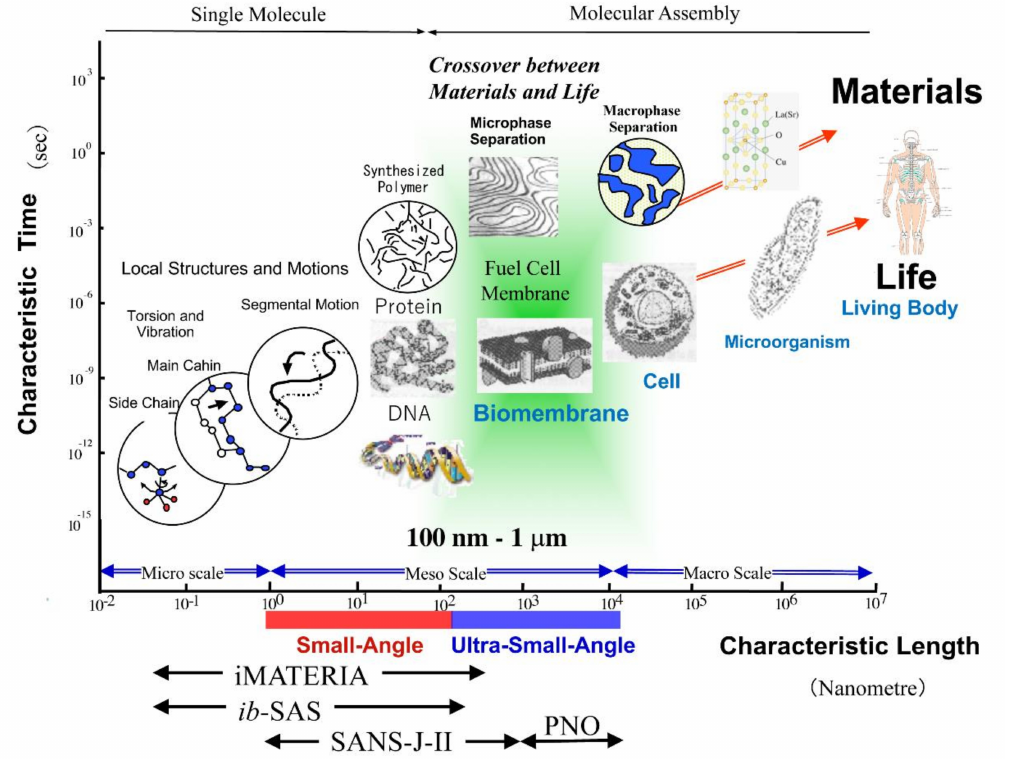
Figure 1. Schematic diagram of hierarchical structures describing materials and life appearing from atomic to macroscopic scales. The length scales covered by small-angle neutron scattering spectrometers in the Tokyo area are